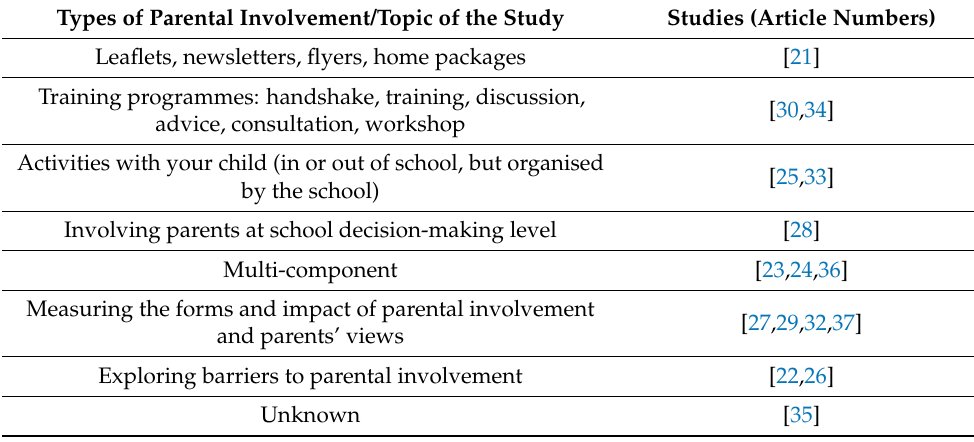
Table 6. Studies categorised by the types of parental involvement and the topic of the study. Types of Parental Involvement/Topic of the